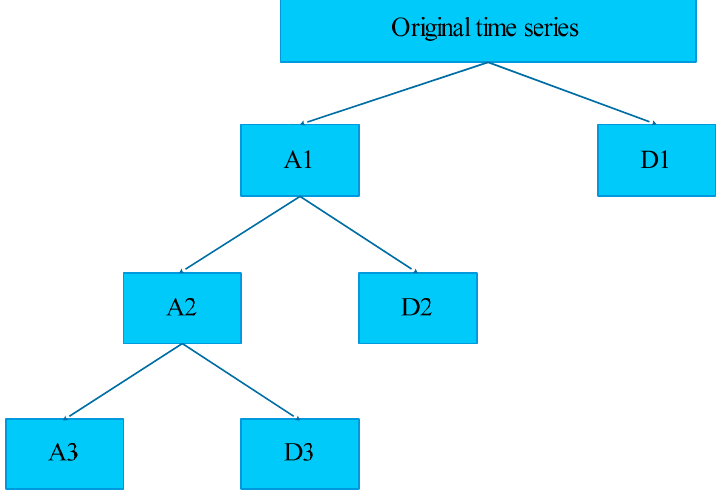
Figure 3. Multi-level decomposition process.